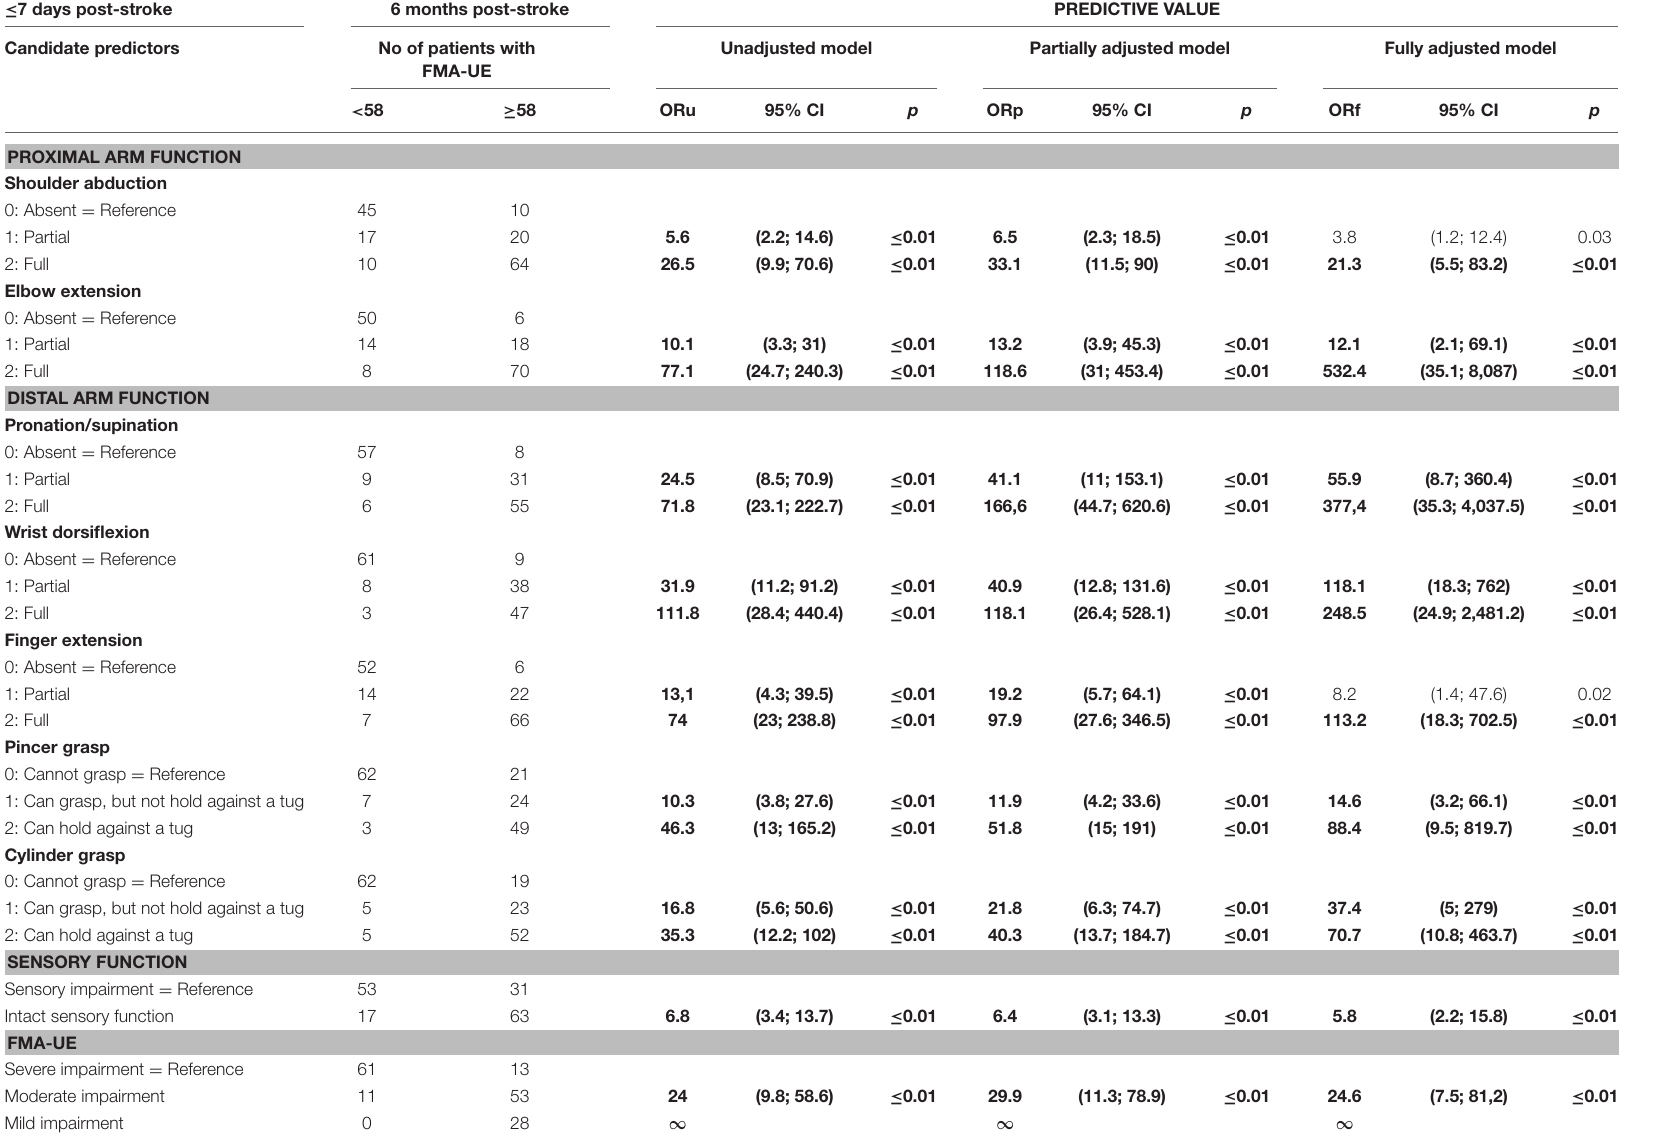
95% CI, 95% confidence interval; FMA-UE, the motor section of the Fugl-Meyer Assessment of Upper Extremity (0–66 points); ORu, odds ratio, unadjusted; ORp, odds ratio adjusted for sample, sex, age, living arrangement; ORf, odds ratio adjusted for sample, age, sex, living arrangement, previous stroke, type of stroke, affected dominant hand, leg paresis, aphasia, stroke severity, pre-stroke physical activity level, number of hospital days, and number of days from stroke onset to the assessment of candidate predictors. P ≤ 0.01 are in